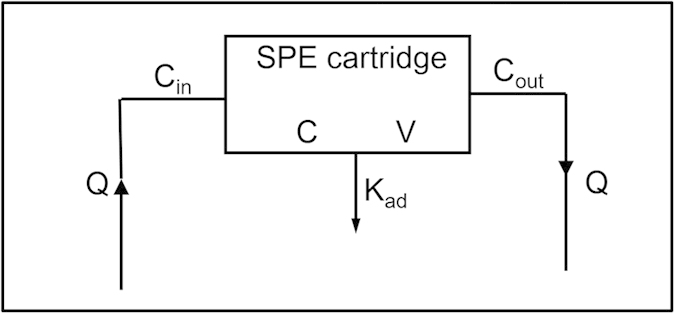
The online SPE model of drugs.Q represented the flow rate of SPE cartridge, Cin and Cout represented respectively the drug concentration in the incoming and outgoing SPE cartridge. C and V were separately the drug concentration in SPE cartridge and the volume of SPE cartridge. Kad represented the adsorption constant of the SPE cartridge to drugs.